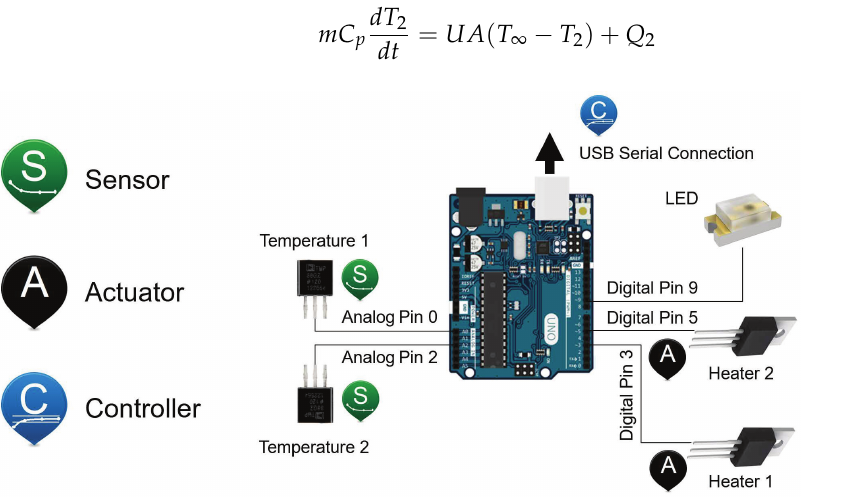
Figure 3. Small-scale temperature control unit [65].